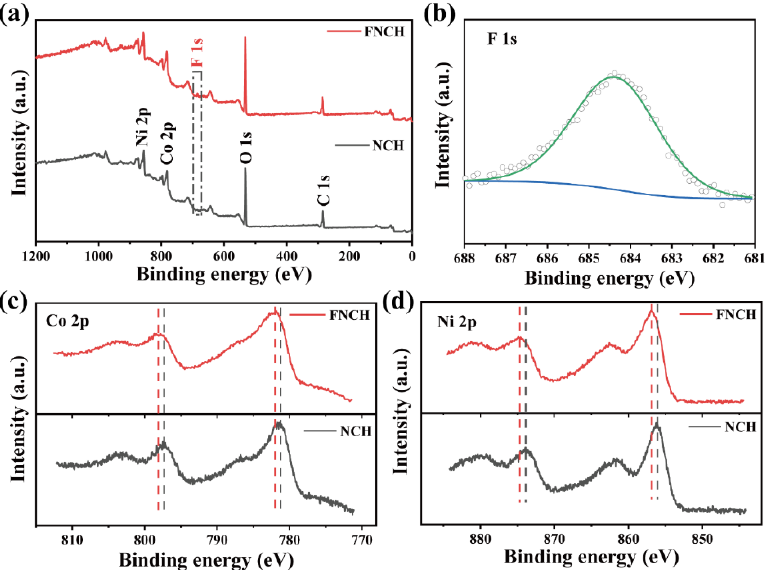
Figure 3. Analysis of the state of surface. ( a ) XPS survey spectra of FNCH and NCH; ( b ) F 1s spectra of FNCH; Comparison of Co 2p ( c ) and Ni 2p spectra ( d ) between FNCH and NCH.